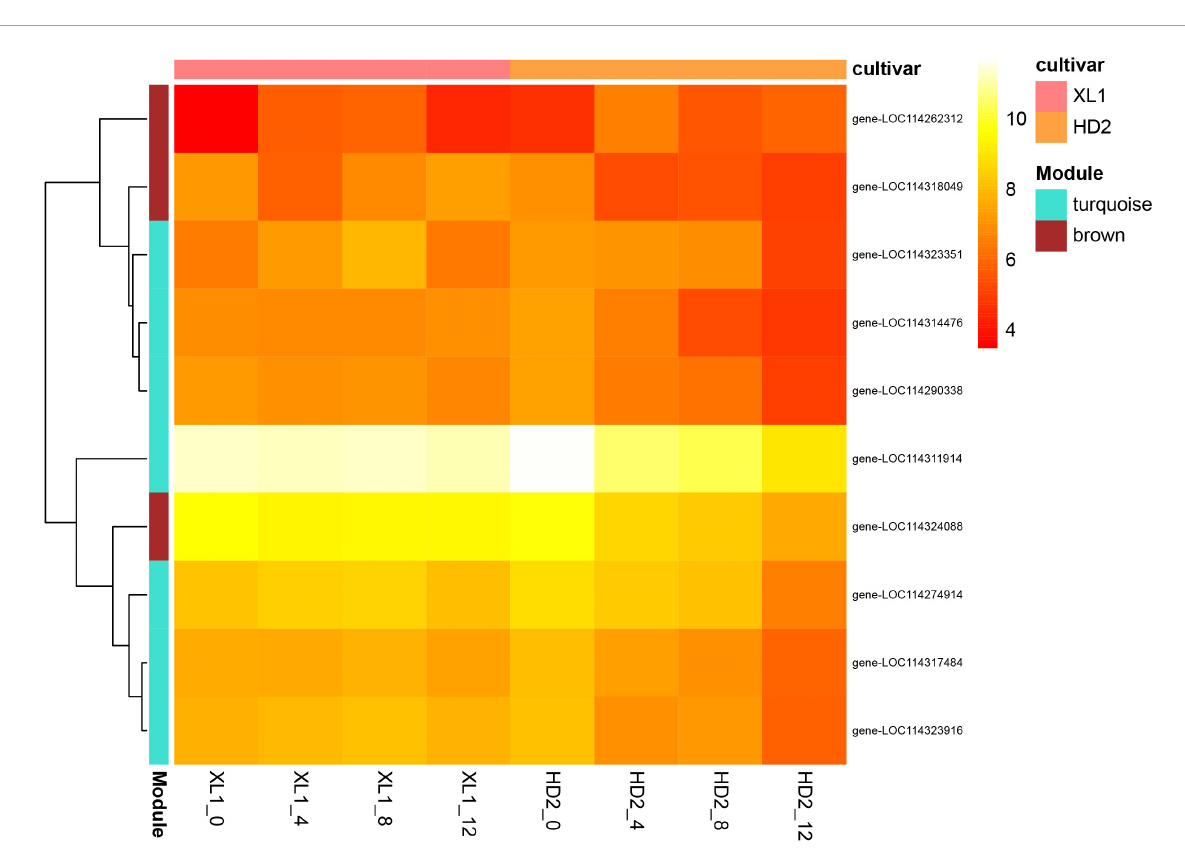
FIGURE11 Expression levels of top ten hub genes of the PPI network. Heatmap showing the expression profiles of the top ten hub genes, the color depth of each cell represents the gene expression level by log 2 (FPKM + 1), and the values of clustering distance were “correlation” and the clustering algorithms was